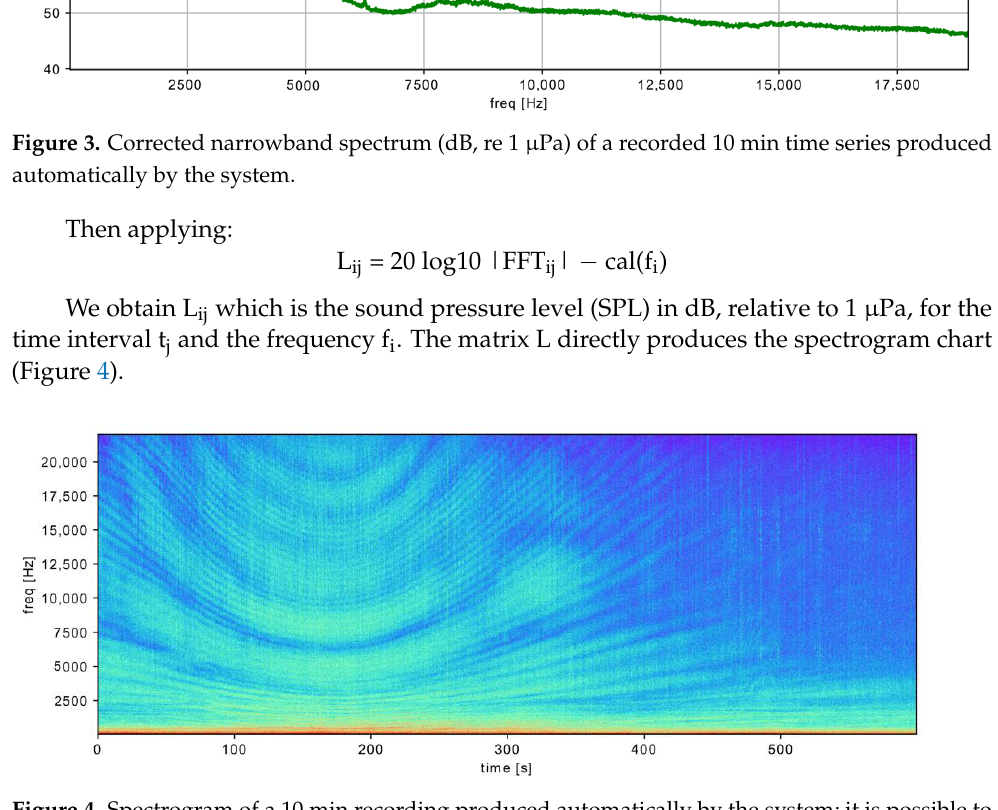
Figure 4. Spectrogram of a 10 min recording produced automatically by the system; it is possible to notice the movement of a noise source (very likely a small boat).